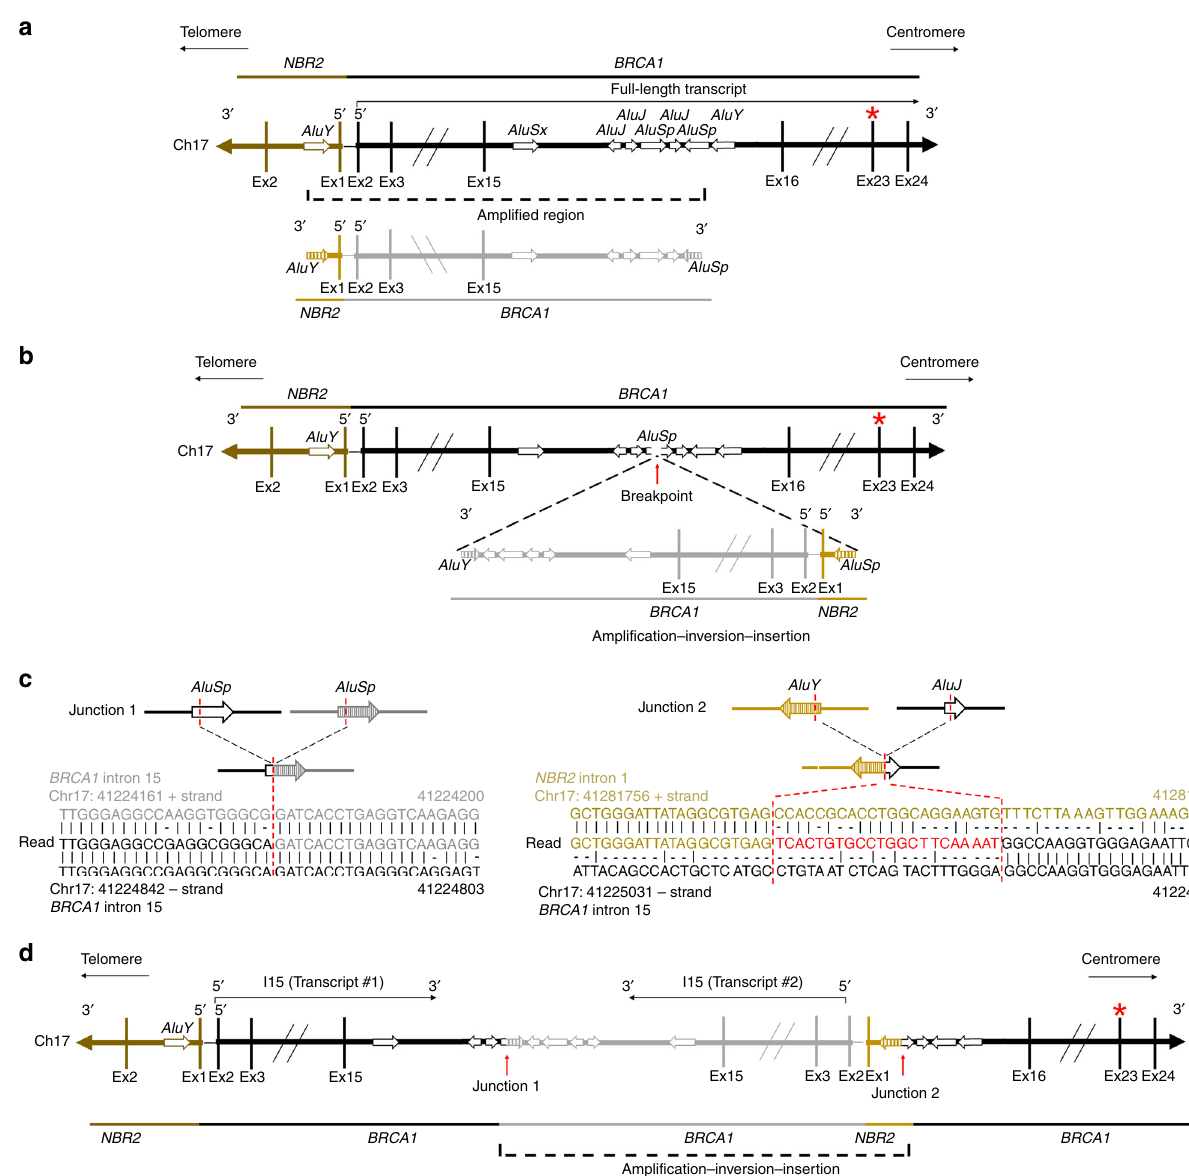
Fig. 3 Alu -mediated rearrangements generate BRCA1-I15. a Schematic showing the NBR2 (brown) and BRCA1 (black) gene region of chromosome 17. Alu sequences are arrows and their orientation relative to the centromere and telomere of chromosome 17 are indicated. Below, the ampli fi ed region detected in SNU-251-RR cells is shown corresponding to NBR2 (gold) and BRCA1 (gray) sequences. The AluY and AluSP sequences at each end of the ampli fi ed region are shaded arrows. SNU-251-RR cells also harbor a non-sense mutation c.5445 G > A located in exon 23 that is indicated with a red asterisk. See Supplementary Fig. 2 and Supplementary Note 1 for more details. b The breakpoint and insertion site are within an AluSp in BRCA1 intron 15, highlighted by a red arrow. The ampli fi ed region shown below is inverted and inserted at the indicated breakpoint. c Alu sequences that combine to form junctions 1 and 2 are shown as arrows. Reads detected by WGS that map to the indicated regions of NBR2 intron 1 and BRCA1 intron 15 are shown. Sequence numbers are the genomic coordinates according to the UCSC genome browser (GRCh37/hg19 assembly). Red dashed lines indicate the exact break location and the corresponding DNA sequences. The read sequence colors correspond to the Alu arrows above from which they derive. There is a 22 bp insertion in junction 2, indicated by red colored sequence. d Schematic showing the rearranged locus detected in SNU-251-RR cells. Because a polyadenylation signal exists in BRCA1 intron 15, transcription ends at intron 15. Therefore, the ampli fi ed copy is capable of producing a second identical BRCA1-I15 transcript. Moreover, the mutation located in exon 23 (red asterisk) is not transcribed in the rearranged